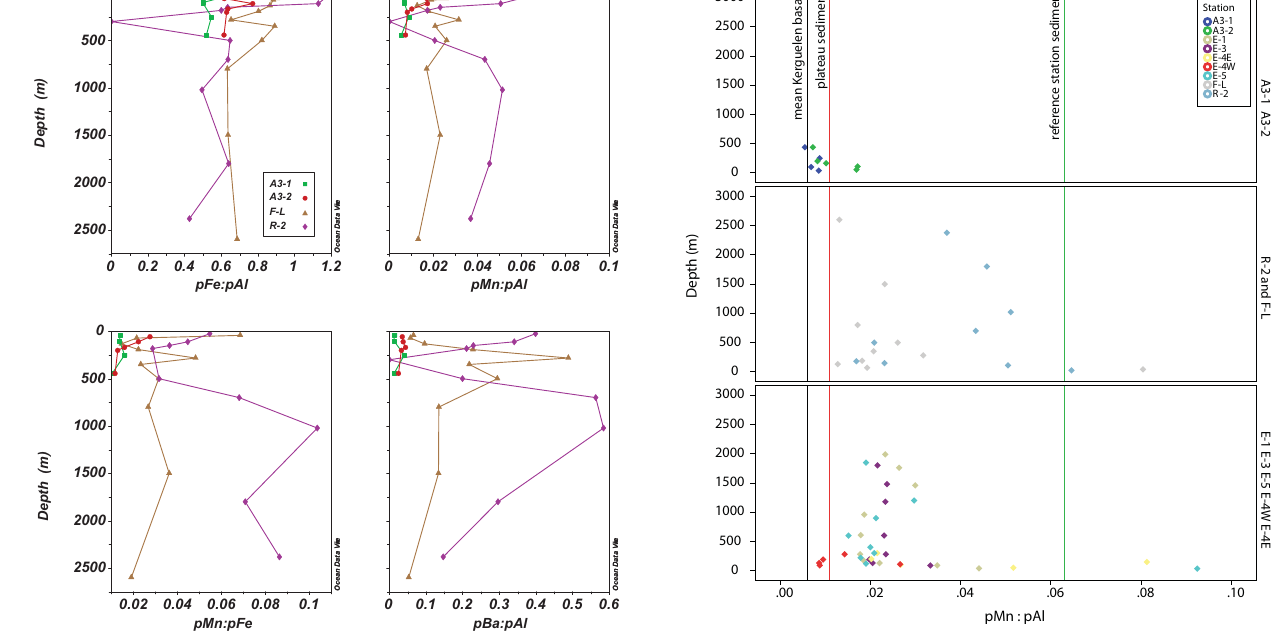
Figure 5. Profiles of elemental ratios at the reference station (R-2), northern PF (F-L) and pre- and post-bloom over the plateau station (A3-1, A3-2). Note the increase in pMn and pBa relative to pAl at station R-2 below 500m.